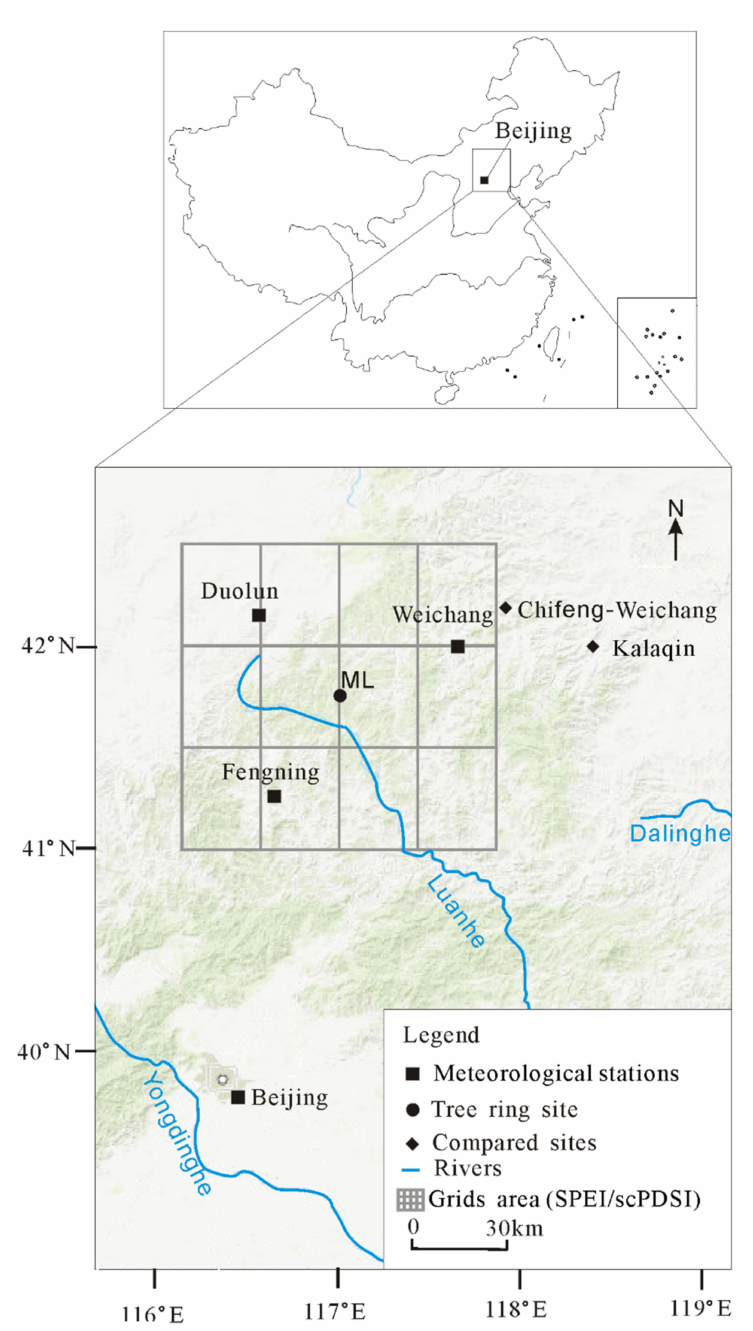
Figure 1. Map of the sampling site. The final figure was modified from a base map created using the USGS National Map Viewer (public domain): http://viewer.nationalmap.gov/viewer/, accessed on 15 November